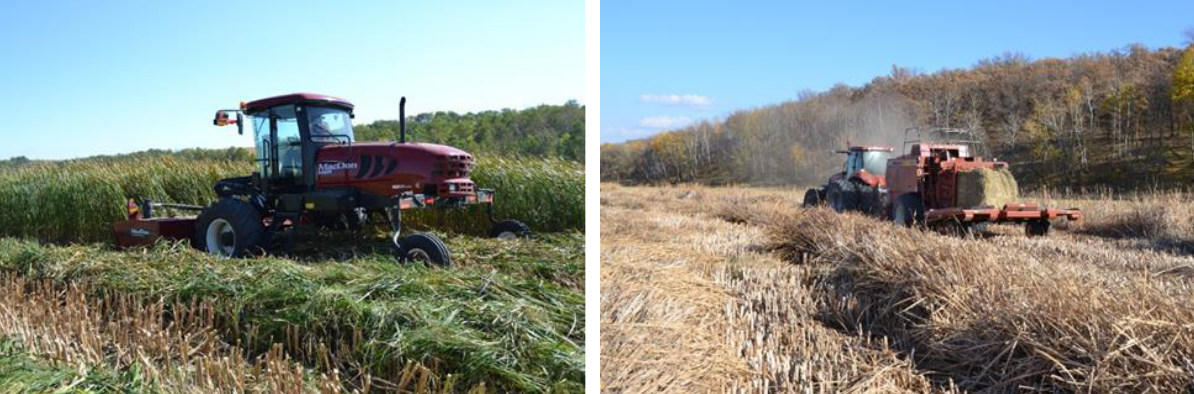
Figure 3. Rotary disc mower swathing cattail ( Typha ) at Pelly’s Lake, Manitoba, Canada during the autumn harvest in September 2013 (left); and baling dry cattail with a large square baler